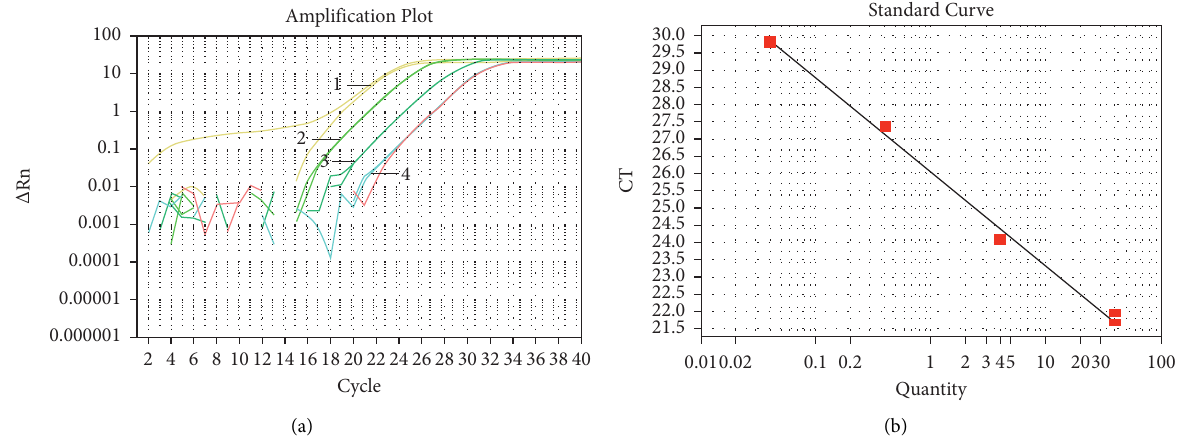
Figure 5: The detection sensitivity of the spt5 gene detection in SYBR Green I quantitative PCR. (a) The final content of DNA in each reaction is as follows: 1, 40ng; 2, 4ng; 3, 0.4ng; 4, 0.04 ng. (b) The standard curve of the quantitative